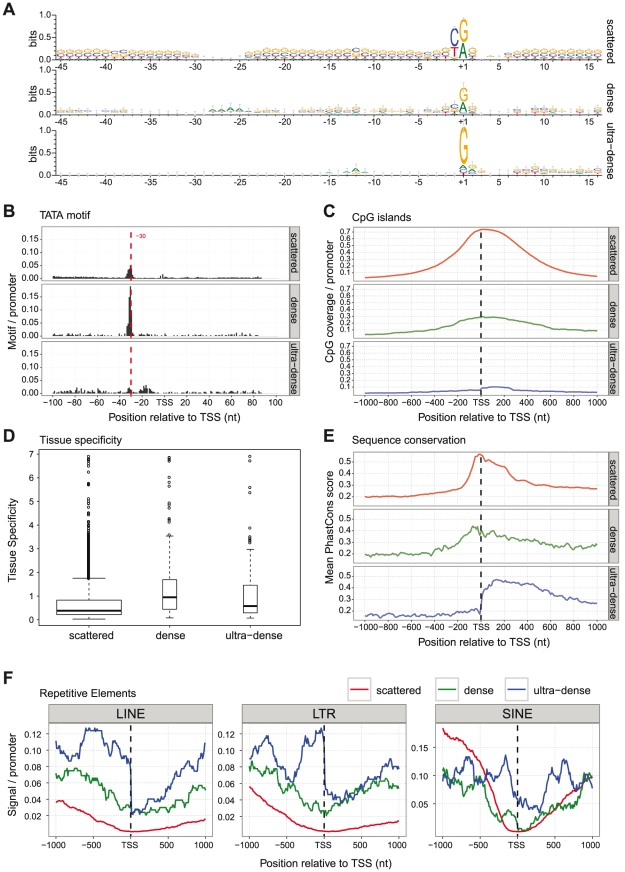
Sequence and expression features of “scattered”, “dense” and “ultra-dense” TSSD classes.For each class, the TSSDs are aligned at their dominant peaks (labeled “TSS” at X-axis). (A) Sequence properties of promoters divided by TSSD class. Sequence logos [68] of the DNA sequence of the TSSDs aligned at the dominant TSS. The x-axis shows the relative genomic positions, +1 indicates TSS. The y-axis shows the information content measured in bits. (B) TATA-box density of promoters divided by TSSD class. The count of predicted TATA sites flanking the dominant TSS (+/−100 nt) of the TSSDs. The X-axis shows the positions of the first T of the TATA site relative to the dominant TSS in the +−100 region; the Y-axis shows the number of predicted sites per TSSD. Note that the absolute frequencies of predicted sites are strongly dependent on the cutoffs, but the relative difference between different TSSDs are not cutoff-dependent. TATA sites are strongly over-represented at around −32 nt in the dense group (middle panel) but are less defined in the scattered group (top panel). The ultra-dense group (bottom panel) shows a small TATA signal located at either −32 nt or around −20 nt. (C) CpG island coverage of promoters divided by TSSD class. The coverage of CpG islands is illustrated in the flanking region (+/−1000 nt) around the TSSs. The X-axis shows the genomic position relative to the TSSs; the Y-axis shows the number of nucleotides covered by a CpG islands/TSSD. (D) Tissue specificity of TSSD classes. The box-plots show the distribution of the overall tissue specificity, given the class of the TSSD, calculated as the KullbacK-Leibler divergence. The smaller the distance is, the lower is the tissue specificity. (E) Sequence conservation. Sequence conservation is represented as mean PhastCons scores over all sites in the −/+1000 nt flanking region around the TSSs. PhastCons scores vary from 0 to 1, with 1 indicating high conservation. The X-axis shows the genomic position relative to the TSSs; the Y-axis shows the mean PhastCons scores. (F) Occurrence of repetitive elements in promoters divided by TSSD class. The X-axis shows the genomic position relative to the dominant peak of the TSSD; the Y-axis shows the number of nucleotides covered by respective repetitive elements, normalized by the number of TSSD. The transposable elements: LINE (top), LTR (middle) and SINE (bottom) are overrepresented in the ultra-dense core promoters (in blue) around the dominant TSS.